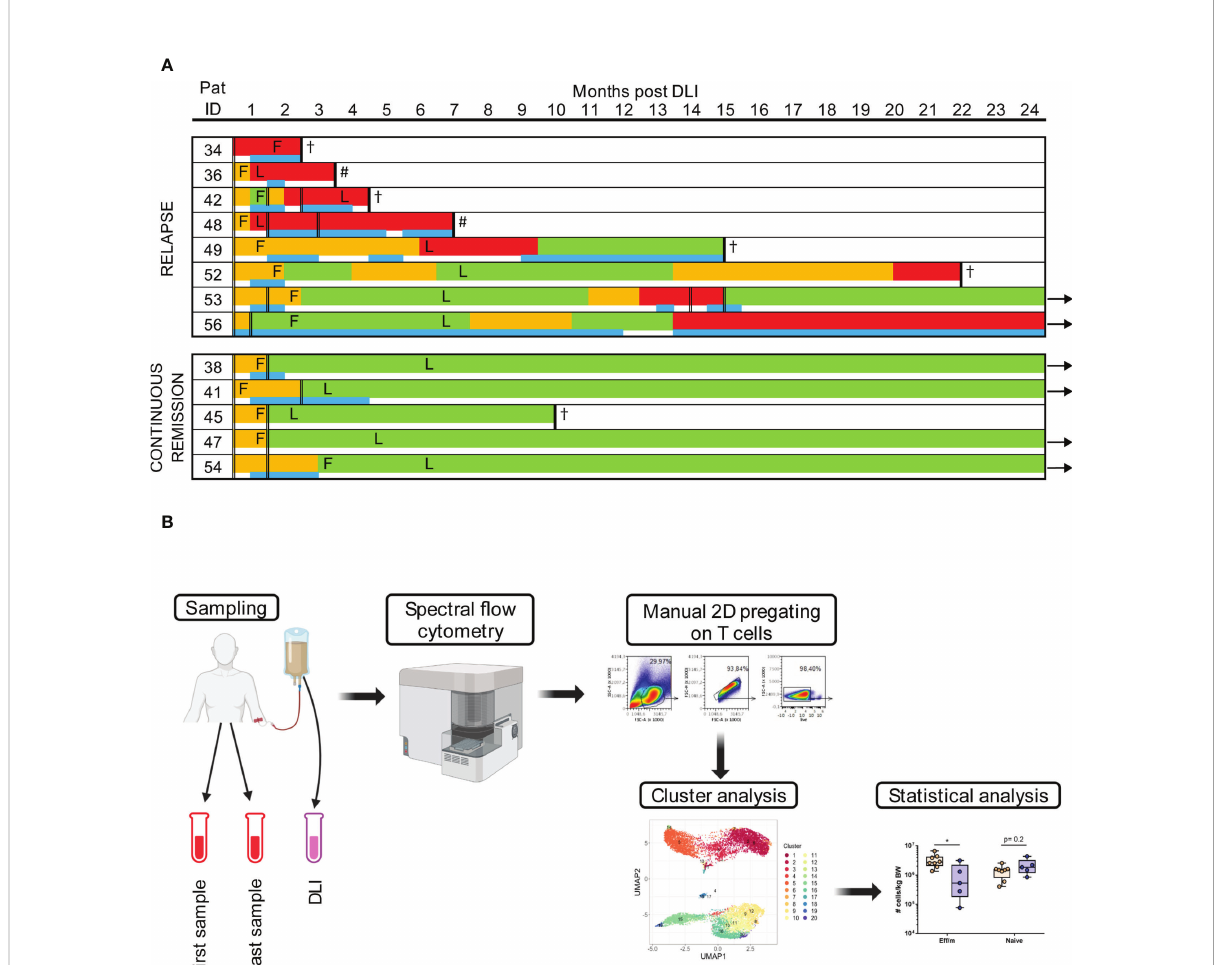
FIGURE 1 Study work fl ow and response to DLI. (A) Every patient is represented by one line with color coding giving details of timing and duration of GVL (green), noGVL (orange) and relapse (red) and the timing of concomitant antineoplastic treatment (blue). Application of DLIs is shown with double lines, timing of the fi rst (F) and last (L) samples post DLI is marked in the time line of each patient. Follow-up time was 24 months. Arrows indicate continued survival beyond the study follow up, # indicates second allogeneic hematopoietic stem cell transplantation, † indicates death. (B) The work fl ow is shown. After sampling, PBMCs were measured with spectral fl ow cytometry. Data was then manually pre- gated on T cells for cluster analysis, which were subsequently statistically evaluated. Figure 1B was created with